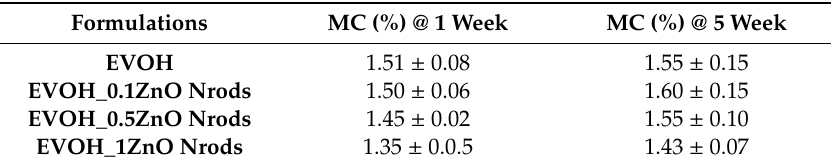
Table 4. Moisture content of EVOH-based systems.